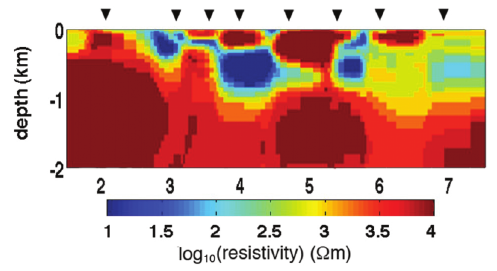
Fig. 11. 2D joint inversion of CSAMT TM and TE modes across the profile in fig. 1, relative to 10000 τ =1 Ω m for the resistivity ρ 0 of the starting model, for the trade-off parameter. A horizon of 2 km bgl is